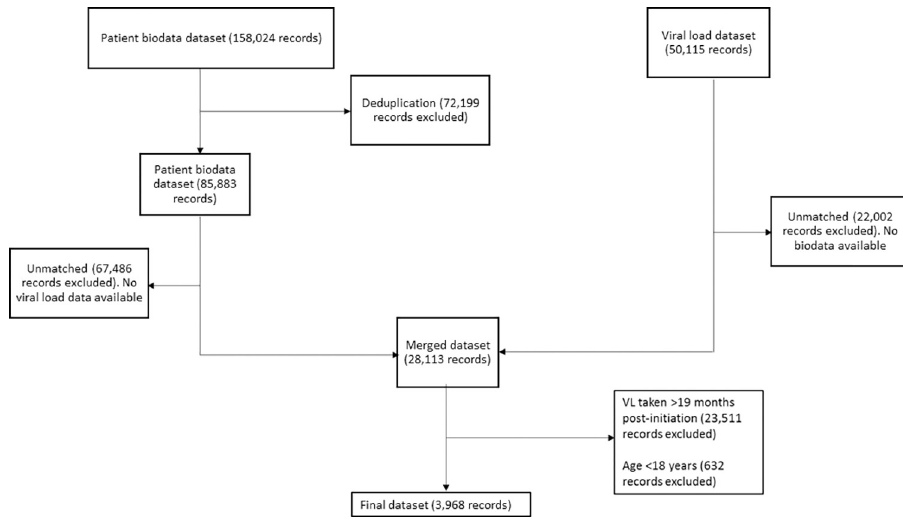
Fig 1. Flow diagram of data deduplication and cleaning to derive final dataset for scoring tool. https://doi.org/10.1371/journal.pone.0271520.g001 Model validation. We calculated the total risk score of each individual by summing the individual parameter scores determined in the final risk model. The AUC for the probability of the risk score to correctly predict unsuppressed viral load was 0.55 (95% CI: 0.52 to 0.56).